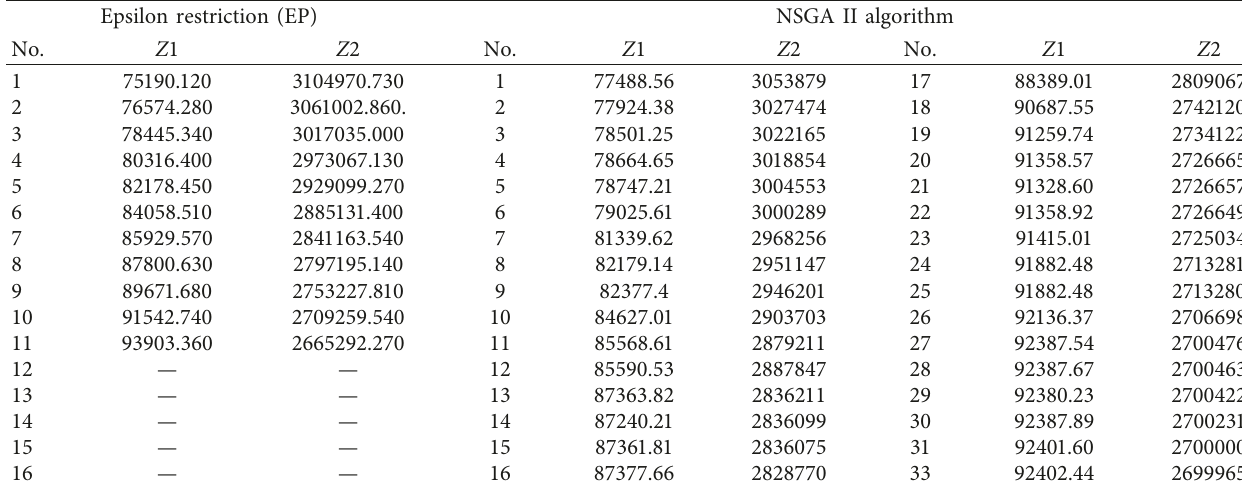
Table 10: A set of answers obtained from solving the financing